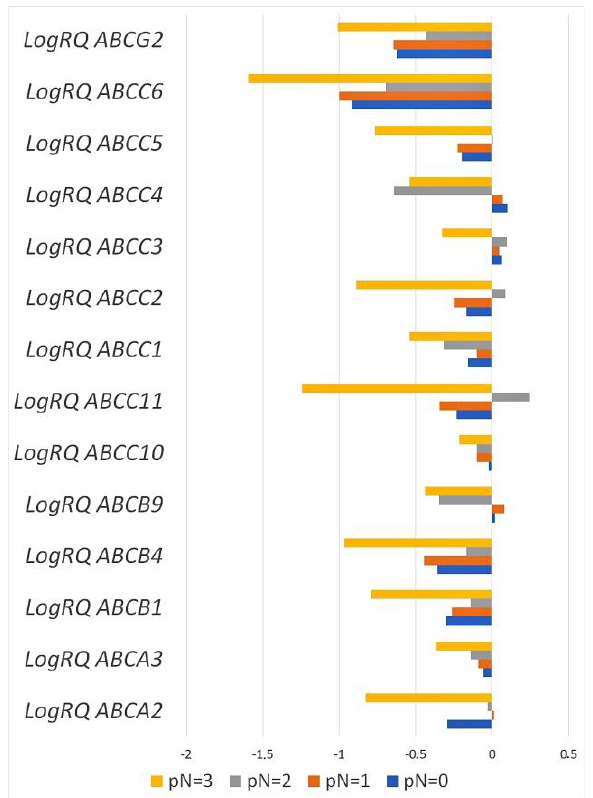
Figure 8. Mean expression values of selected genes from the ABC family in patients classified into 4 groups depending on the presence of metastases to lymph nodes (pN0 — no metastases to the regional lymph nodes, pN1 — micrometastases or metastases in 1 – 3 axillary lymph nodes, pN2 — metastases in 4 – 9 axillary lymph nodes, and pN3 — metastases in 10 or more axillary lymph nodes).